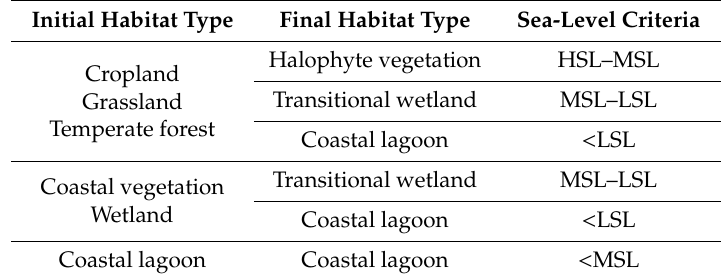
Table 3. Transition rules determining habitat shifts and associated sea-level criteria.